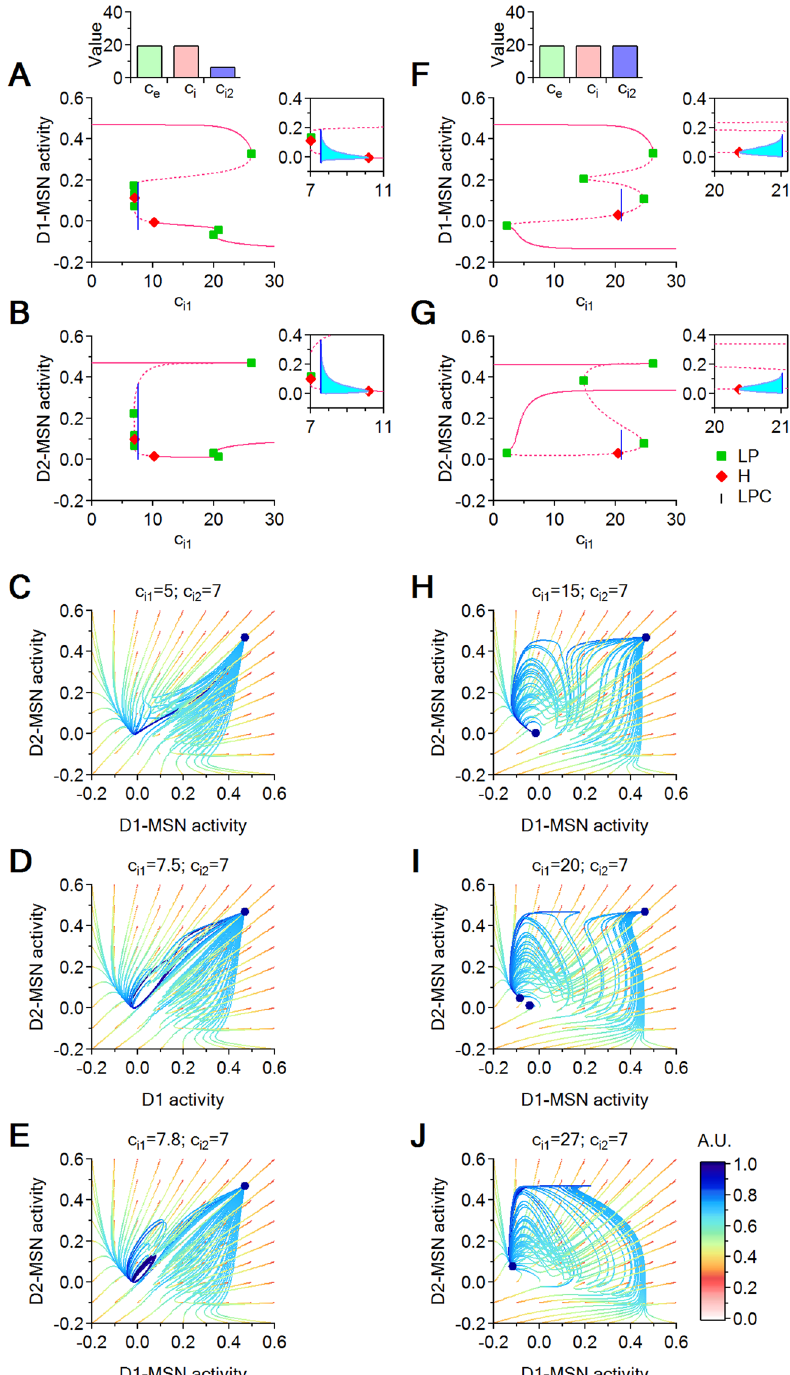
Figure 6. Bifurcation diagrams with respect to c and phase space trajectories for = c 7 and different values of i 1 i 2 . ( A , B ) Bifurcation diagrams showing the D 1 and D 2 coordinate projections for increasing values of c , when c i i 1 1 = c 7 . The equilibrium curve (pink) displays six LPs (green squares) and two H points (red diamonds). The i 2 insets show the cycles born at the H points (cyan). At the leftmost supercritical H point ( = c 7 ), the saddle i 1 equilibrium changes to a saddle cycle. At the rightmost supercritical H point ( = . c 10 2 ), the stable equilibrium i 1 changes to a stable cycle, which survives until the LPC at = . c 7 6 (blue line). ( C – E ) Representation of the seven i 1 dimensional trajectories via their projections onto the 2-dimensional ( D 1, D 2) plane, for a grid of initial conditions within the ( D 1, D 2) slice. Trajectories are evolving in time from red to blue. The position of the attractors (equilibria and cycles) is marked with a dark blue circle. ( F , G ) As in ( A , B ), for = c 20 . ( H – J ) As in i 2 ( C – E ), for different values of c i 1